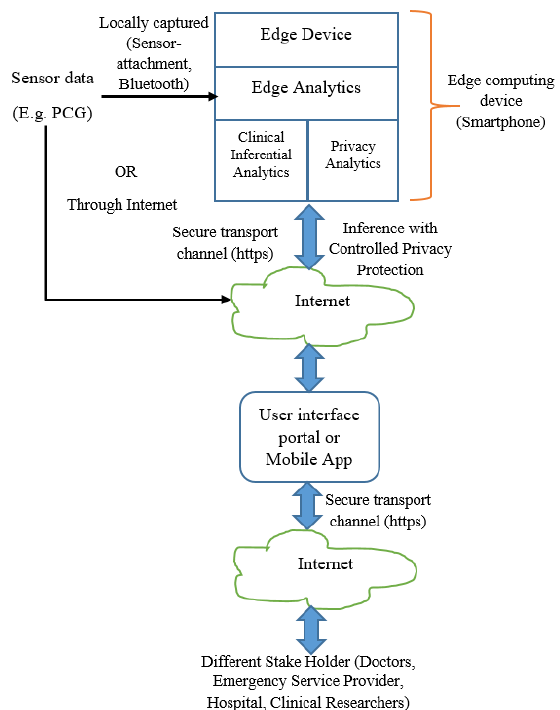
Figure 2. Smart edge analytics for clinical inference and controlled privacy protection: Deployment